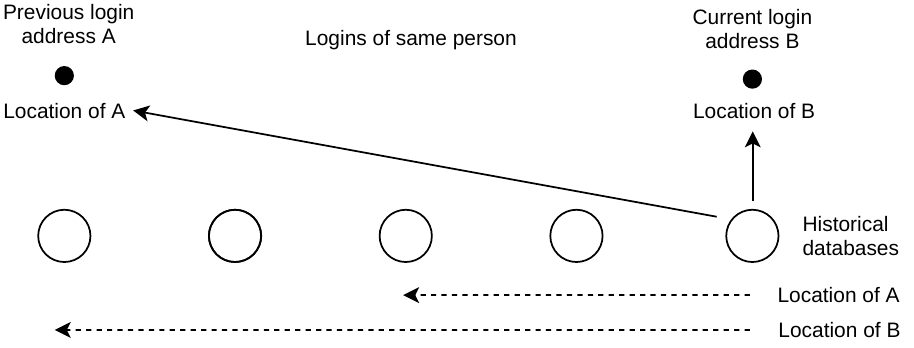
Figure 12. ID theft prevention use-case. The time difference between current and previous login (hours) is not in relation to the time difference between past databases